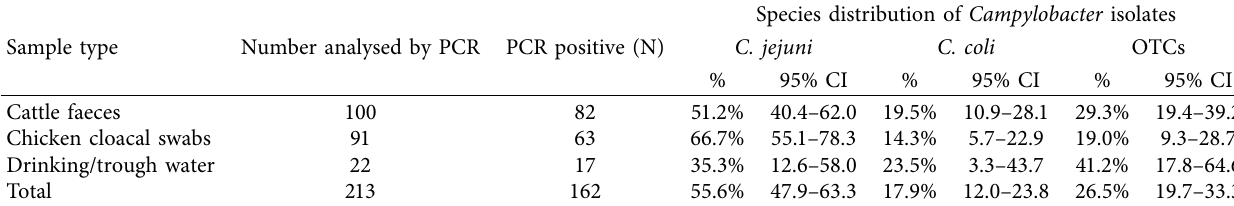
Table 5: Molecular typing of thermophilic Campylobacter species across sample